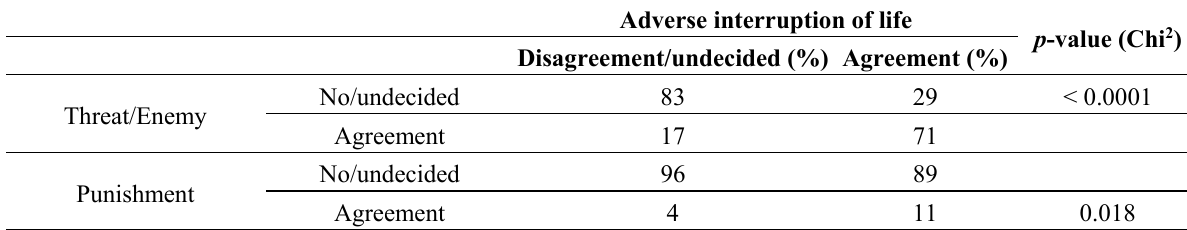
Table 3. Interpretations of Illness with respect to adverse interruption (cross